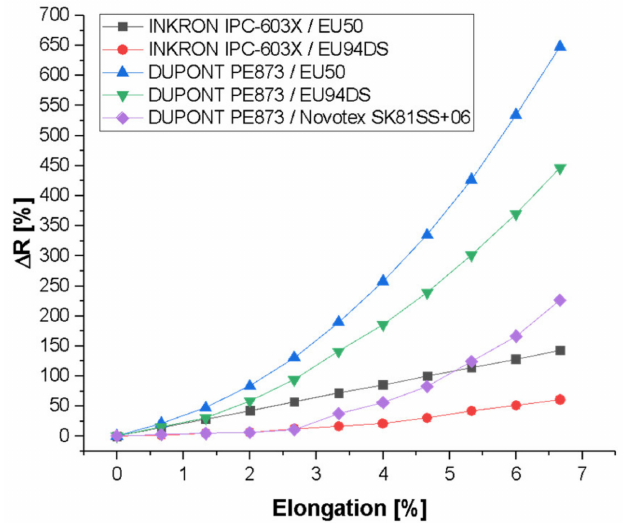
Figure 11. Percentage variation of the resistance value according to the percentage elongation for the 1.5 mm-wide